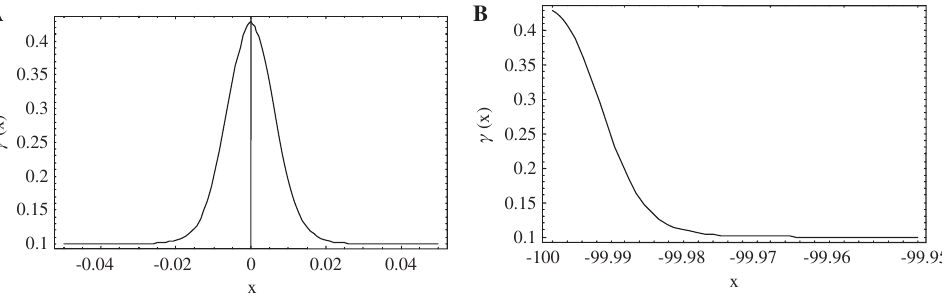
Figure 2 (A) Profile of the strain nucleus at the center of the specimen. (B) Profile of the strain nucleus at the edge of the